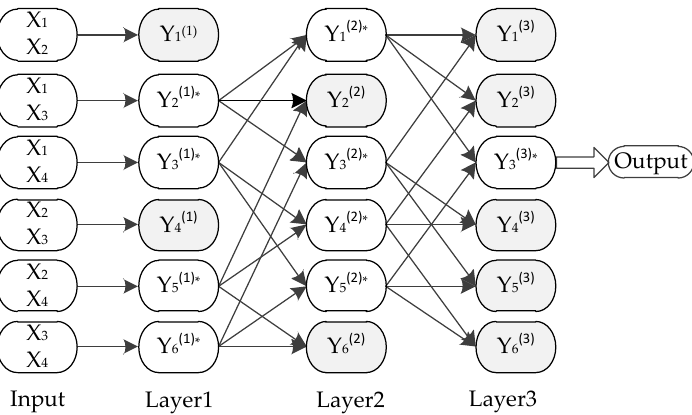
Figure 1. Group method of data handling (GMDH) network architecture.